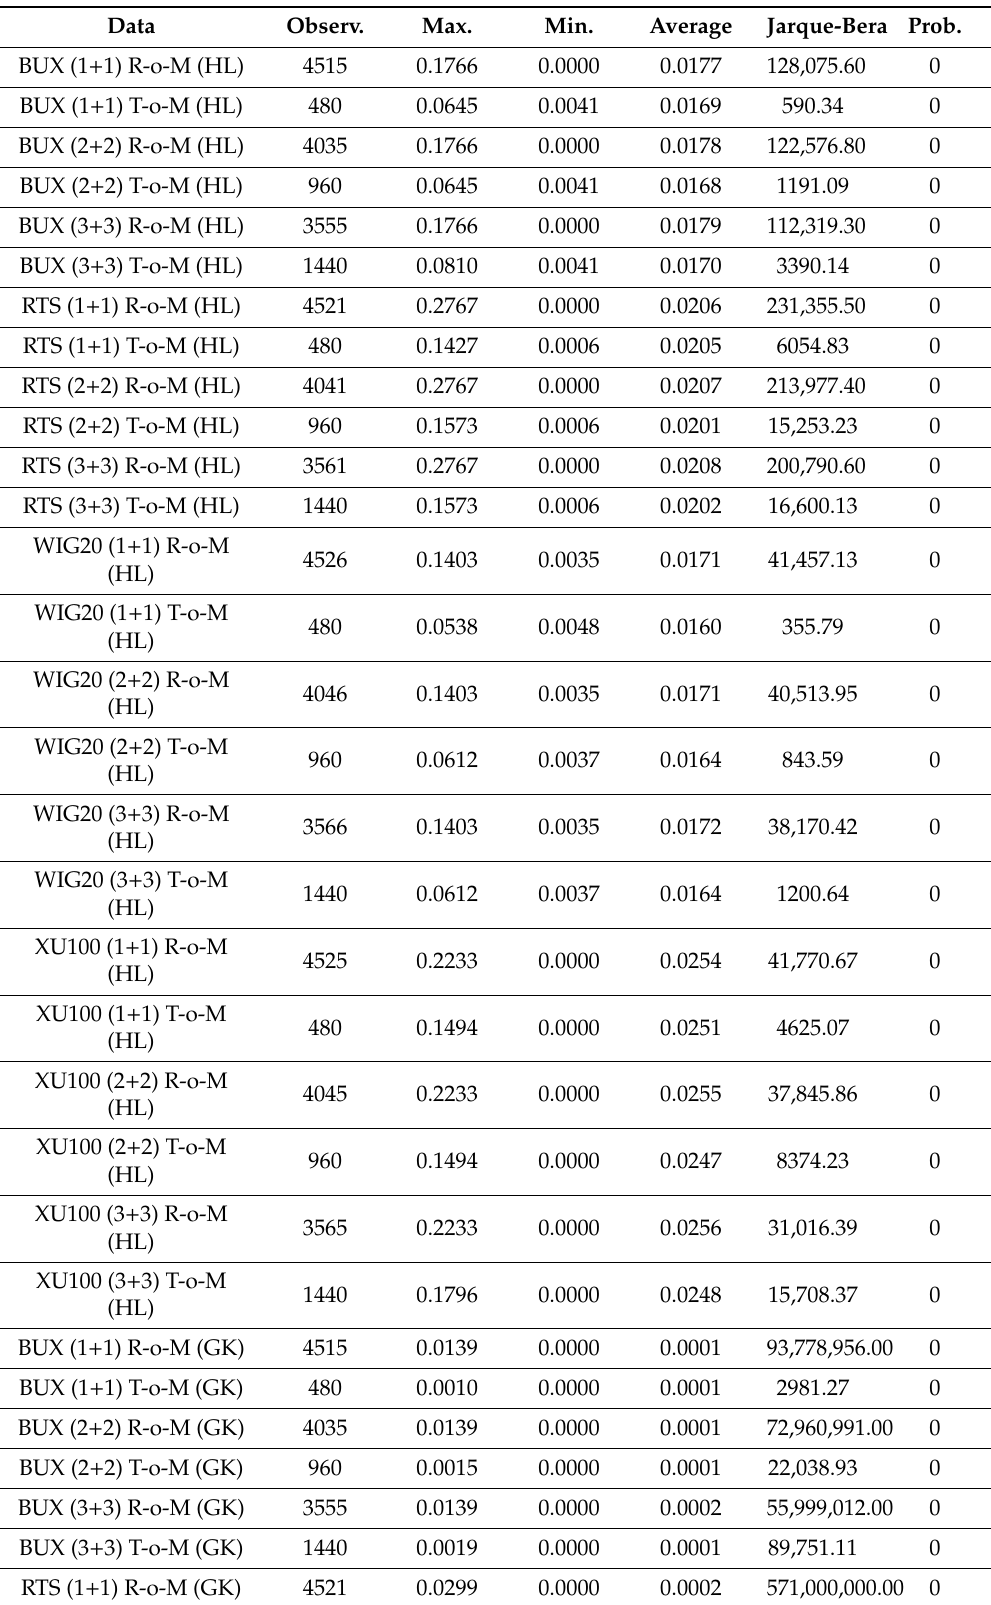
Table A2. Descriptive